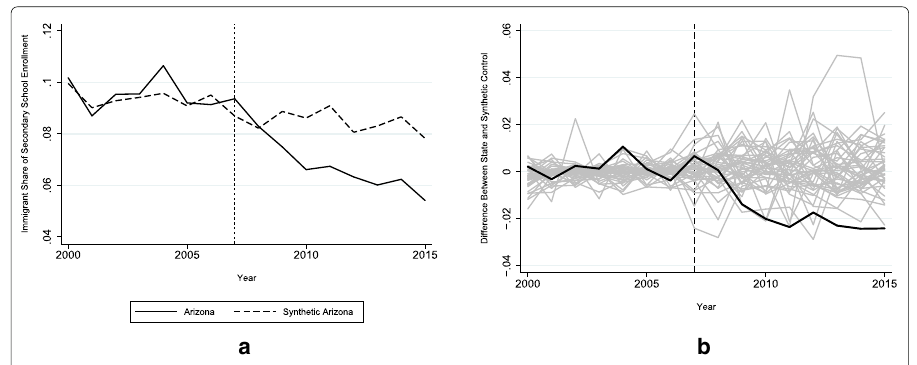
Fig. 5 LAWA and share of immigrants in secondary school. a Share of immigrants. b Permutation